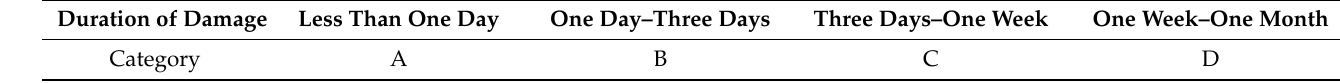
Table A8. Duration of critical infrastructure damage [24].